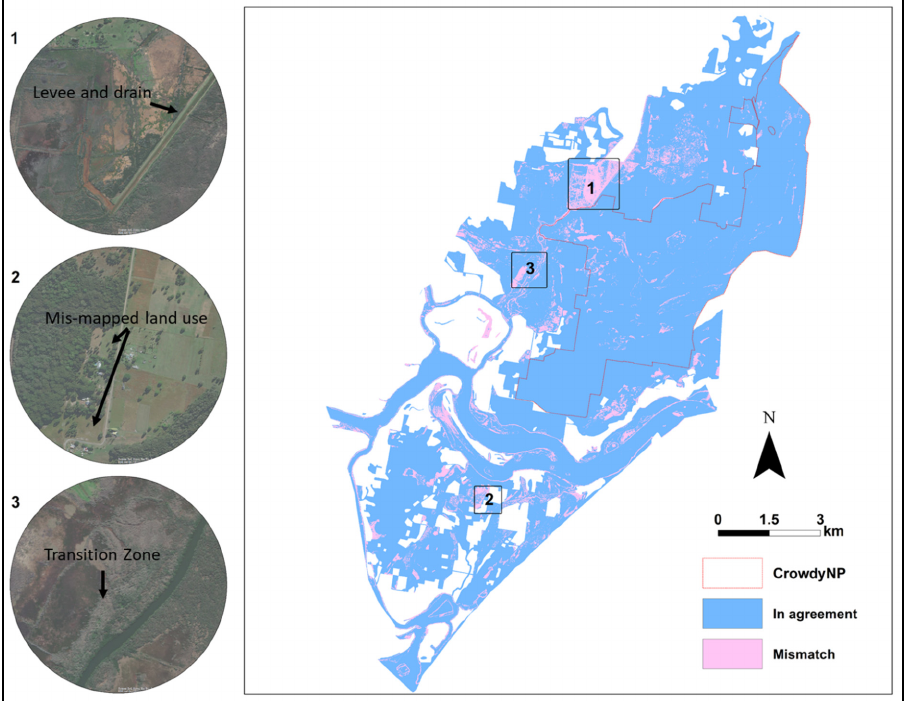
Figure 2. The areas of agreement and mismatch between mapped and predicted land cover in the focused study area of the Manning River Estuary. The inset aerial photos show that the mismatches commonly occurred at hydrologically interrupted native vegetation (the levee and drain in Inset map 1 ), mis-mapped land use in the original land-use map ( Inset map 2 , cleared pasture mapped as grazed native vegetation), and the wetland transition zone ( Inset map 3 , the transition areas between Saltmarsh/Swamp and Forest).